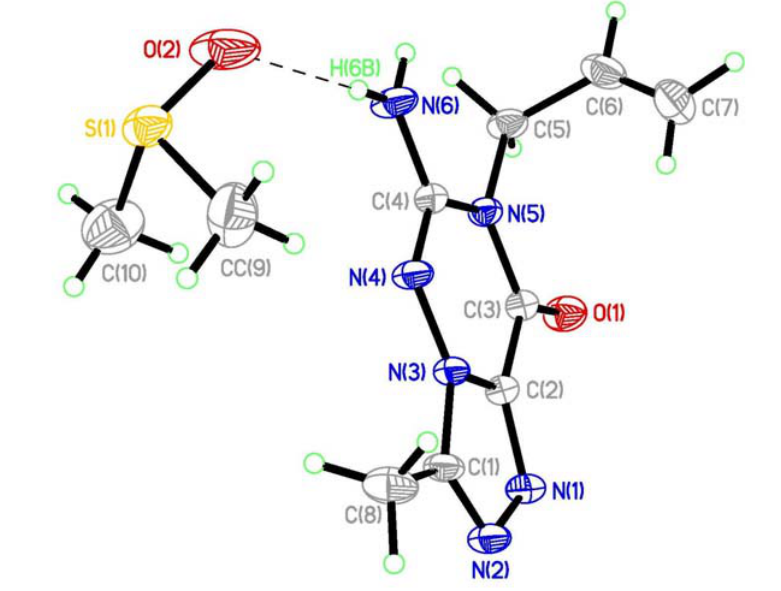
Figure 1. ORTEP drawing and atom labelling scheme of the compound 3 (attached to DMSO) with thermal ellipsoids drawn at the 30% probability level.